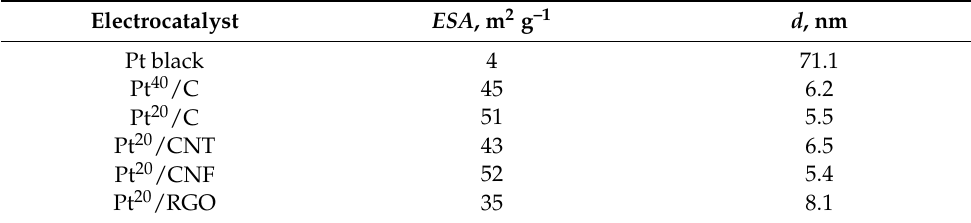
Table 1. ESA and average particle size ( d ) of the electrocatalysts.